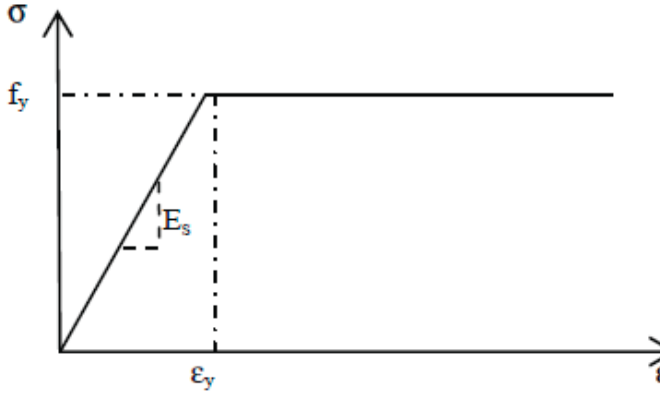
Figure 3. Stress-strain behavior of steel reinforcement.